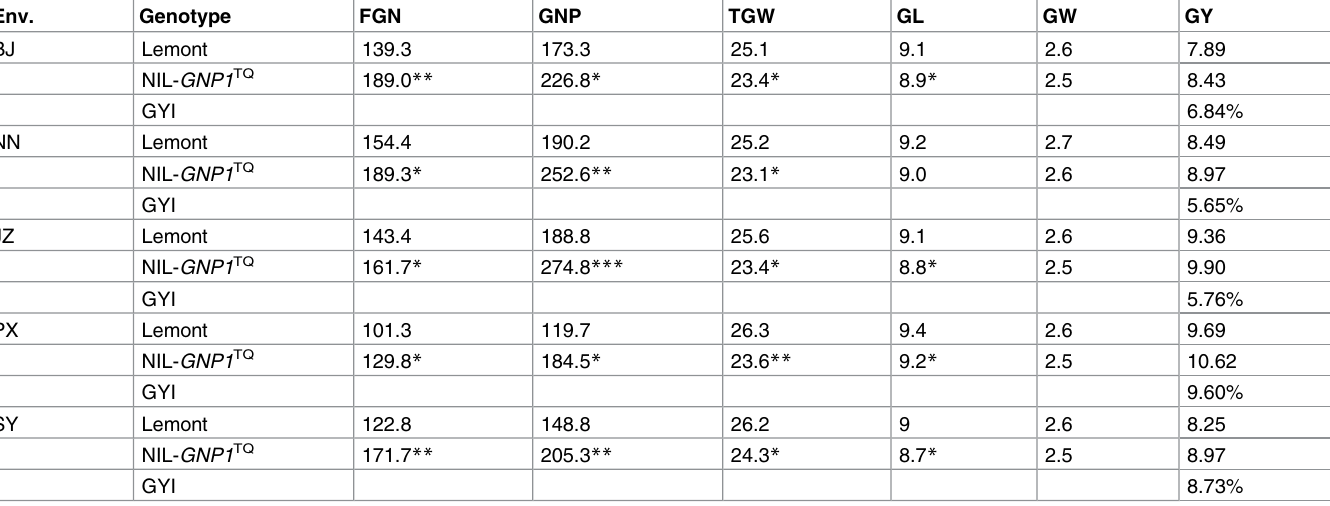
FGN: filled grain number per panicle, GNP: grain number per panicle, TGW: thousand grain weight (g), GL: grain length (mm), GW: grain width (mm), GY: grain yield kg/13.3 m 2 , GYI: GY increase compared to Lemont, BJ: Beijing, NN: Nanning, JZ: Jingzhou, PX: Pingxiang, SY: Sanya. * , ** and *** represent significance differences at p -value (cid:20) 0.05, 0.01, and 0.001,